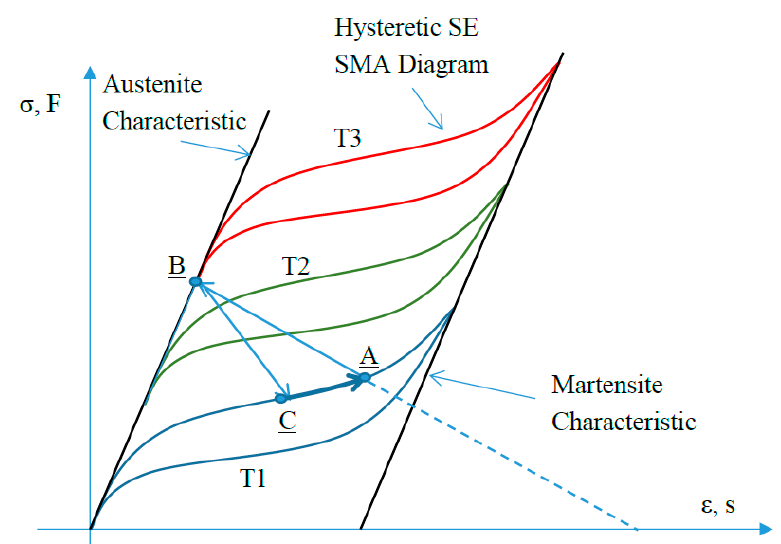
Figure 10. Theoretical behavior of a two-spring SMA system.